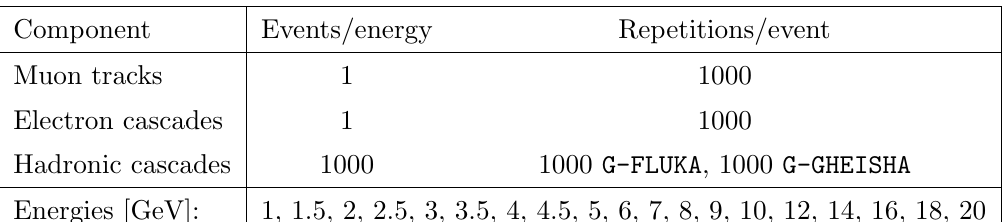
Table 1 . Description of the simulations for each component. Each repetition uses a di(cid:11)erent ran- dom number seed, while for hadronic cascades, each event represents a di(cid:11)erent hadronic (cid:12)nal state.